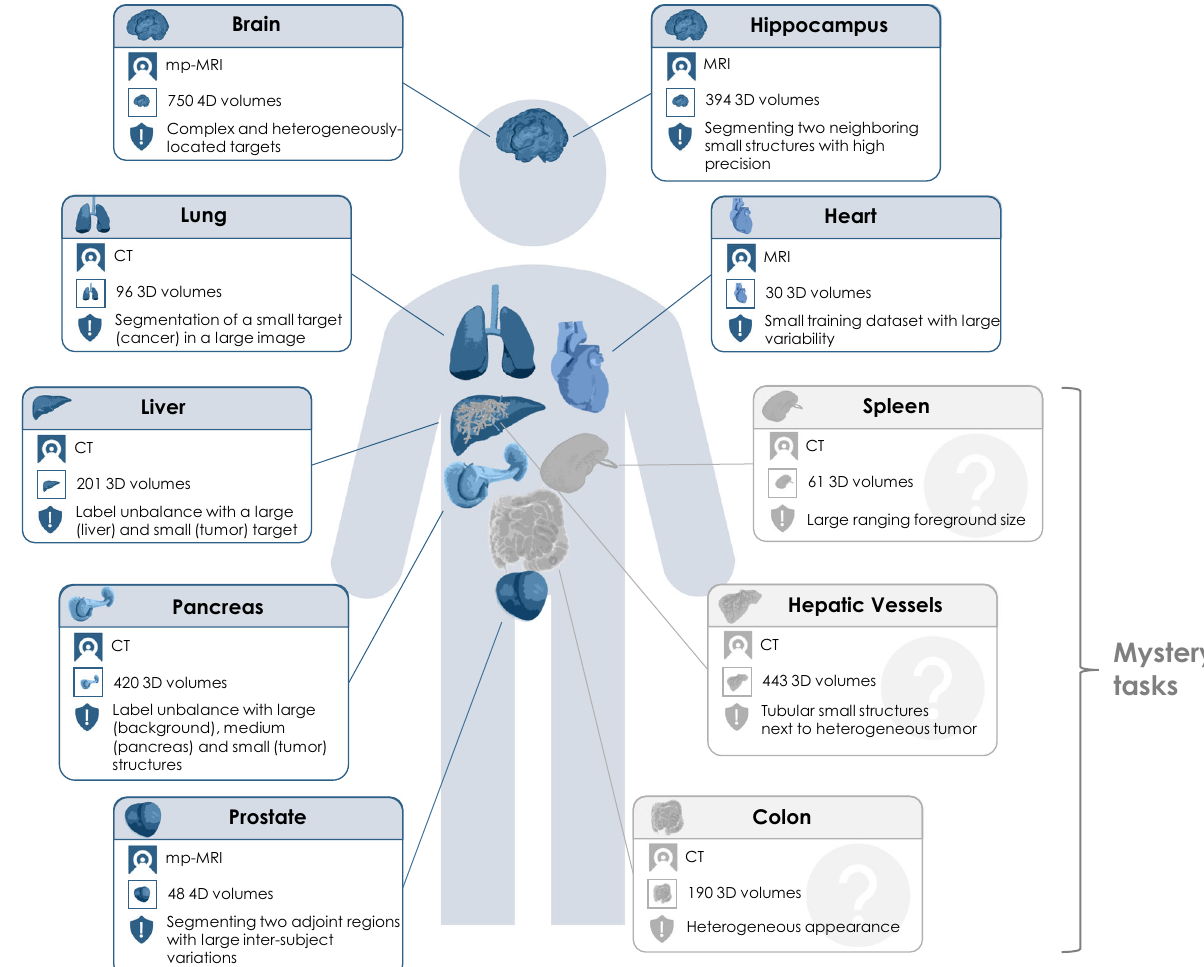
Fig. 1 Overview of the ten different tasks of the Medical Segmentation Decathlon (MSD). The challenge comprised different target regions, modalities and challenging characteristics and was separated into seven known tasks (blue; the development phase: brain, heart, hippocampus, liver, lung, pancreas, prostate) and three mystery tasks (gray; the mystery phase: colon, hepatic vessels, spleen). MRI magnetic resonance imaging, mp-MRI multiparametric- magnetic resonance imaging, CT computed tomography.